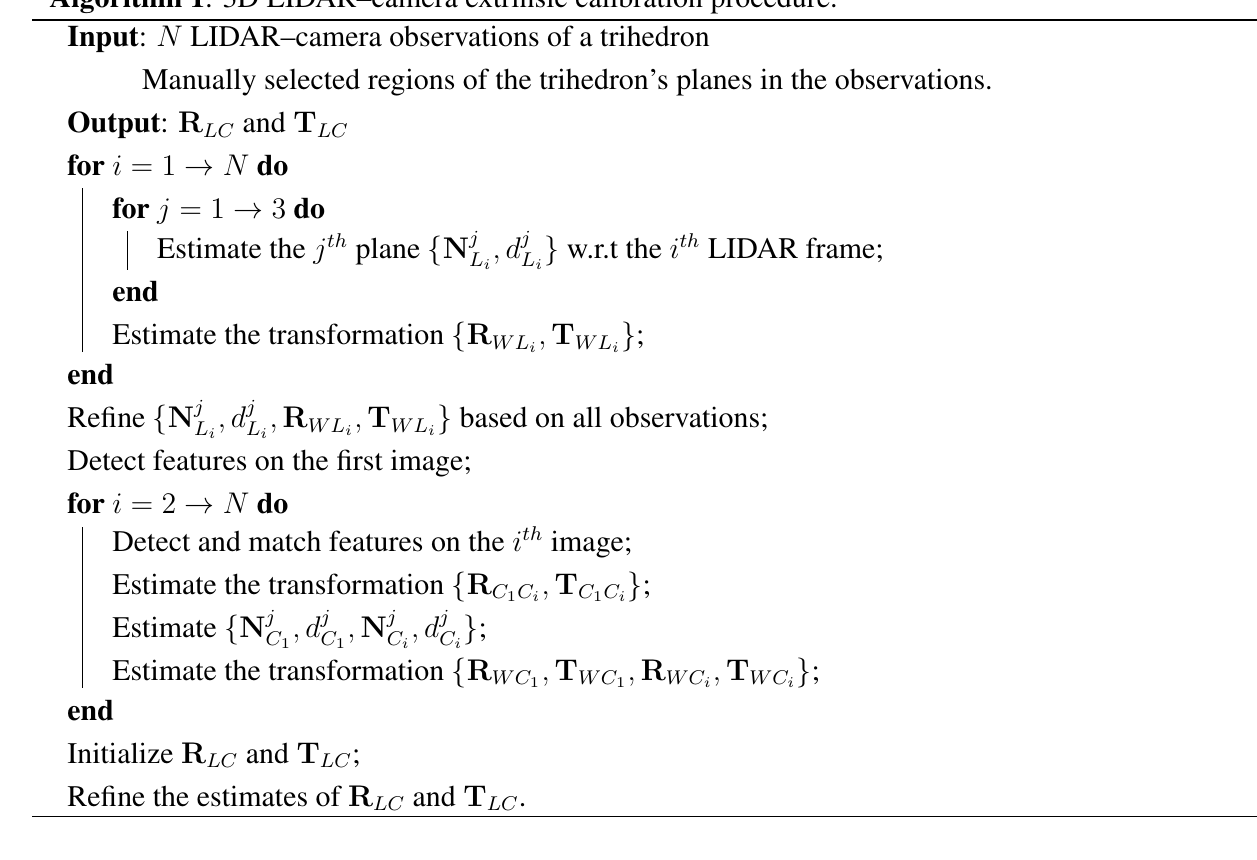
Algorithm 1 : 3D LIDAR–camera extrinsic calibration